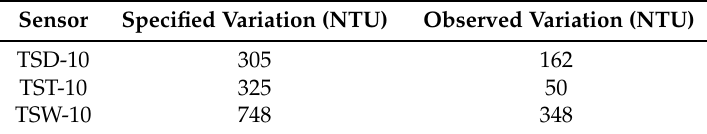
Table 1. Variation between the appliance sensors of the same